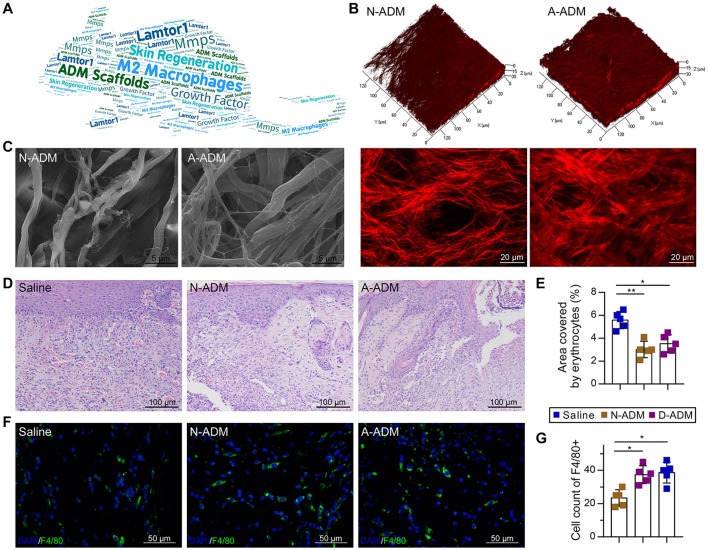
ADM scaffolds induce recruitment of macrophages in skin-wound healing. (A) Word map showing key objectives of the study. (B) TPF/SHG 3D scanning images of N-ADM and A-ADM scaffolds (up); 2D images of N-ADM and A-ADM scaffolds (down). (C) Ultrastructural images of collagen fibrils in N-ADM and A-ADM scaffolds. (D) Representative H&E staining of wounds at 10 days after injury. (E) Quantification of the hemorrhage area in wound tissue (n = 5 from two experiments). (F) Representative micrographs showing immunostaining of macrophages with F4/80 at 10 days after injury. (G) Quantification of F4/80-positive cells in wound tissue (n = 5 mice from two experiments). ANOVA: *P < 0.05, **P < 0.01, ***P < 0.001.